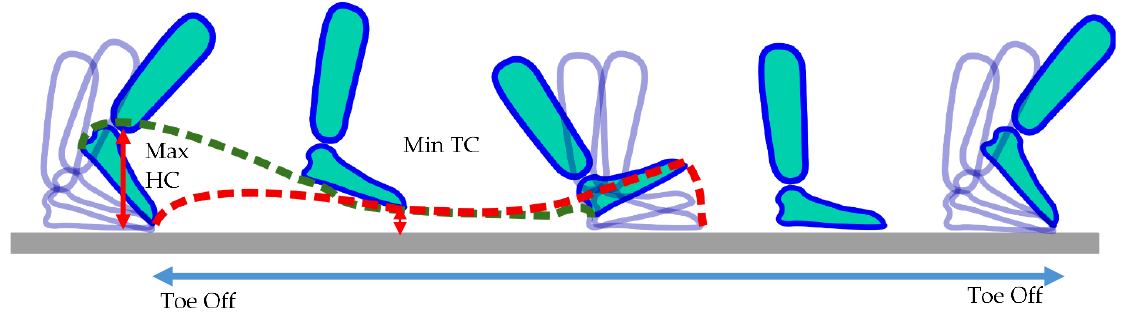
Figure 2. Foot clearance during a step from a single foot. The maximum heel (HC) and minimum toe (TC) clearance are shown with arrows. Two consecutive toe off instants are shown, forming a complete gait cycle.